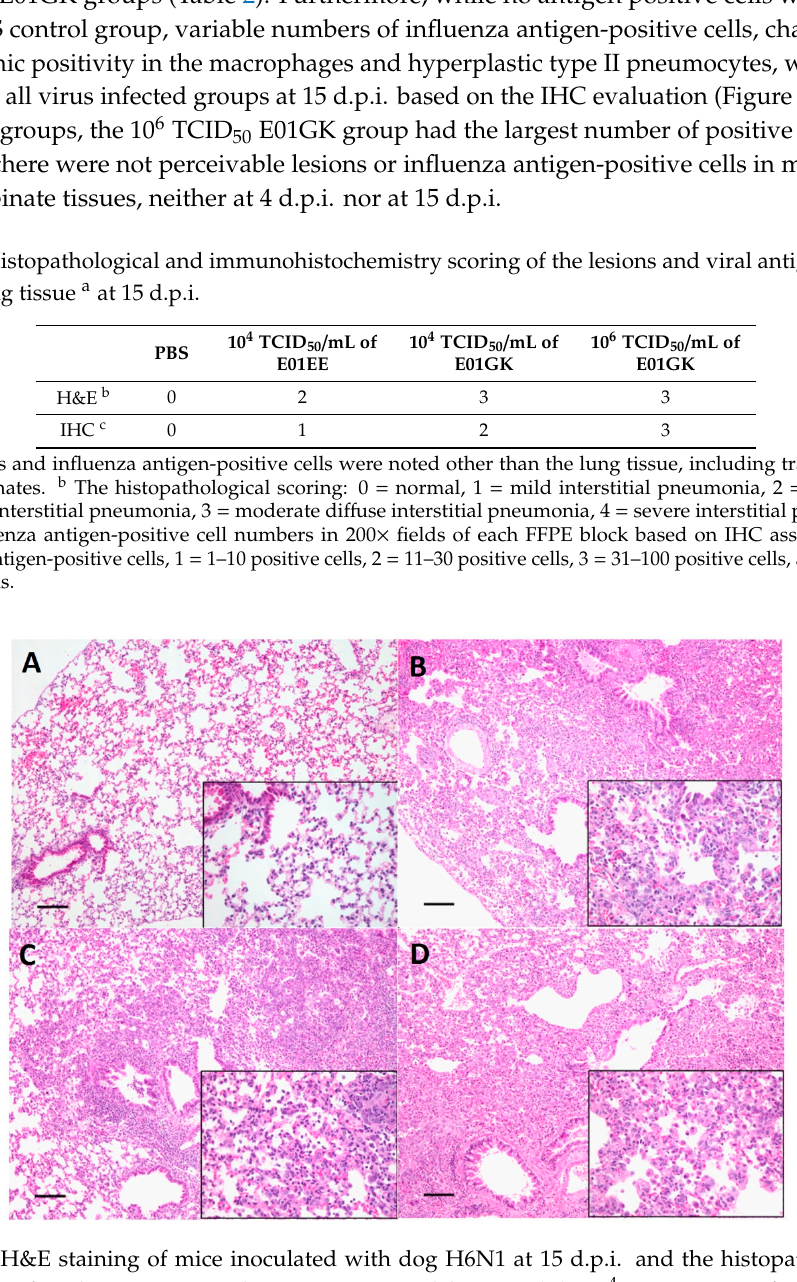
Figure 7. H&E staining of mice inoculated with dog H6N1 at 15 d.p.i. and the histopathological evaluation of pathogenicities in lung tissue caused by PBS ( A ), 10 4 TCID 50 / mL of E01EE ( B ), 10 4 TCID 50 / mL of E01GK ( C ) and 10 6 TCID 50 / mL of E01GK ( D ). The scale bar size is 100 µ m for the left 100 × magnification field. The right down corner is 400 × magnification field.